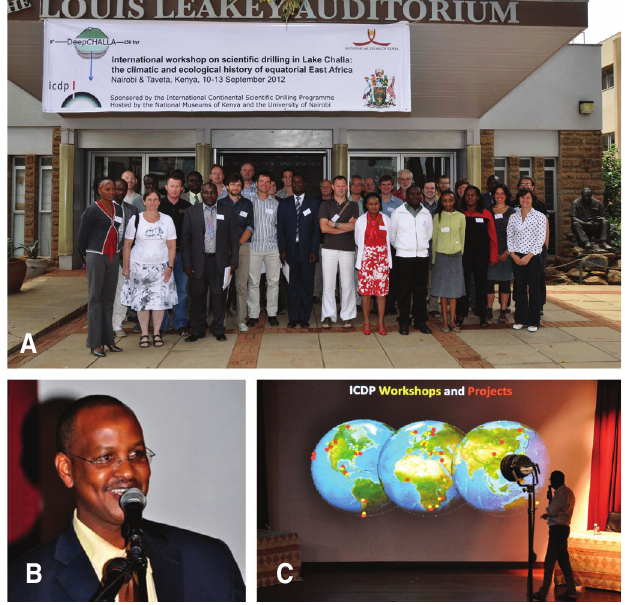
Figure 2. Clockwise: [A] Group photo of participants in the ICDP DeepCHALLA workshop, in front of the Louis Leakey Auditorium of the National Museums of Kenya, host of the workshop. [B] Dr. Gerald Haug presenting the ICDP program. [C] Opening speech by Dr. Idle Omar Farah, Director General of the National Museums of